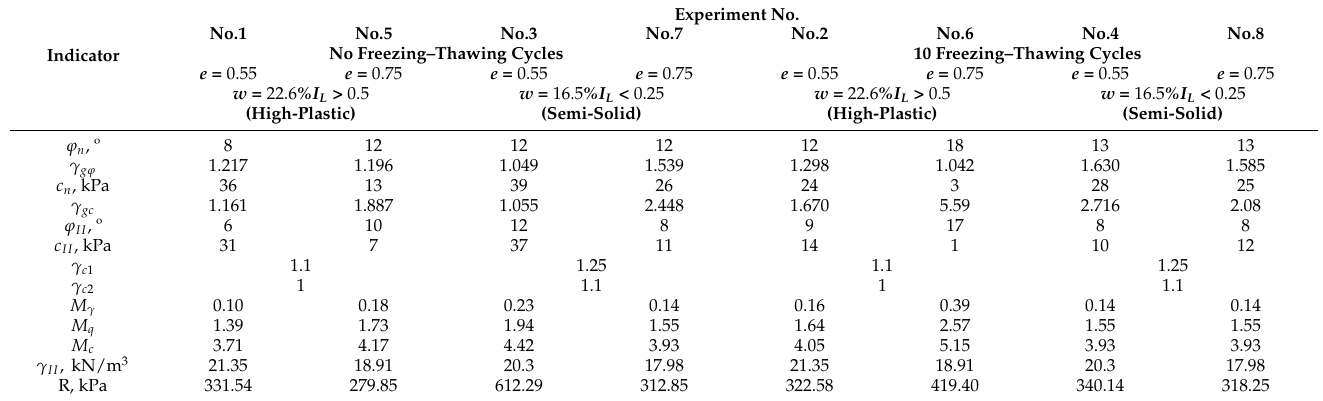
Table 5. Calculation of the engineering characteristics by the analytical method.